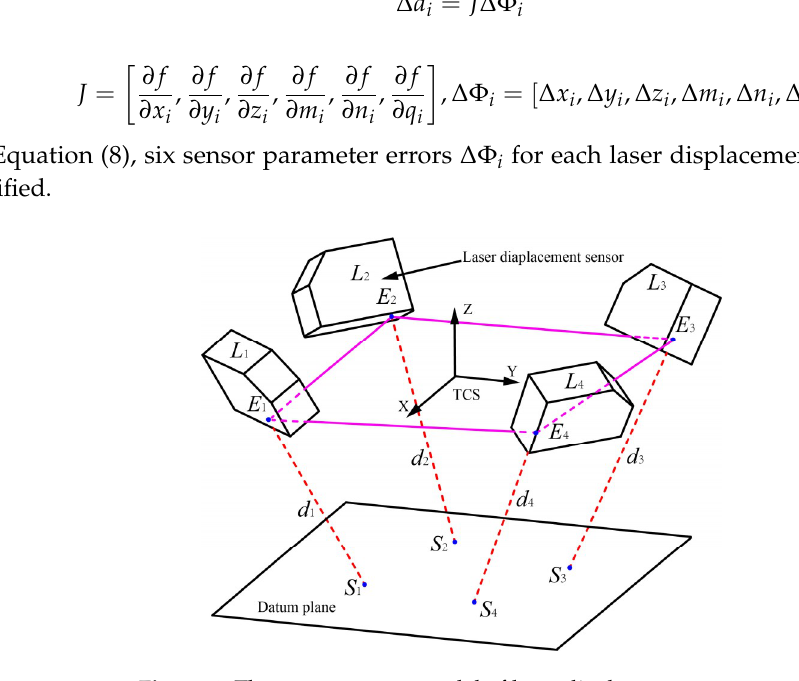
Figure 4. The measurement model of laser displacement sensors.